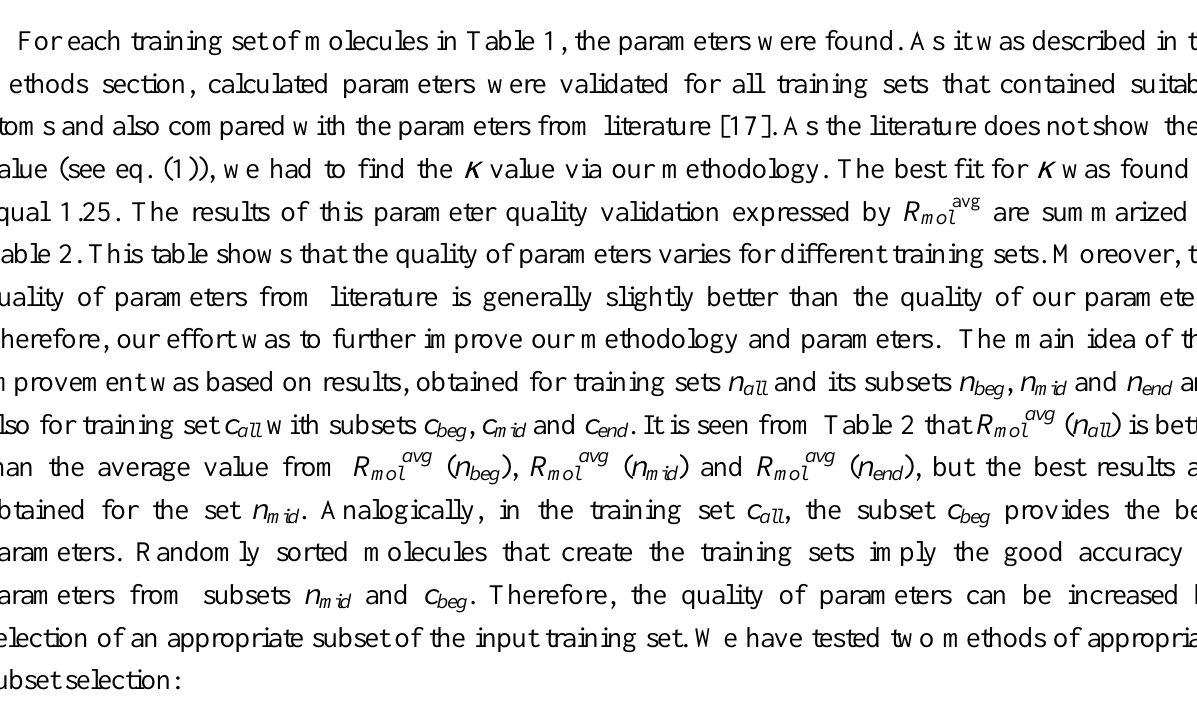
Table 4: EEM parameters A , B and k (see eqs. (1) and (2)) obtained via parameterization using